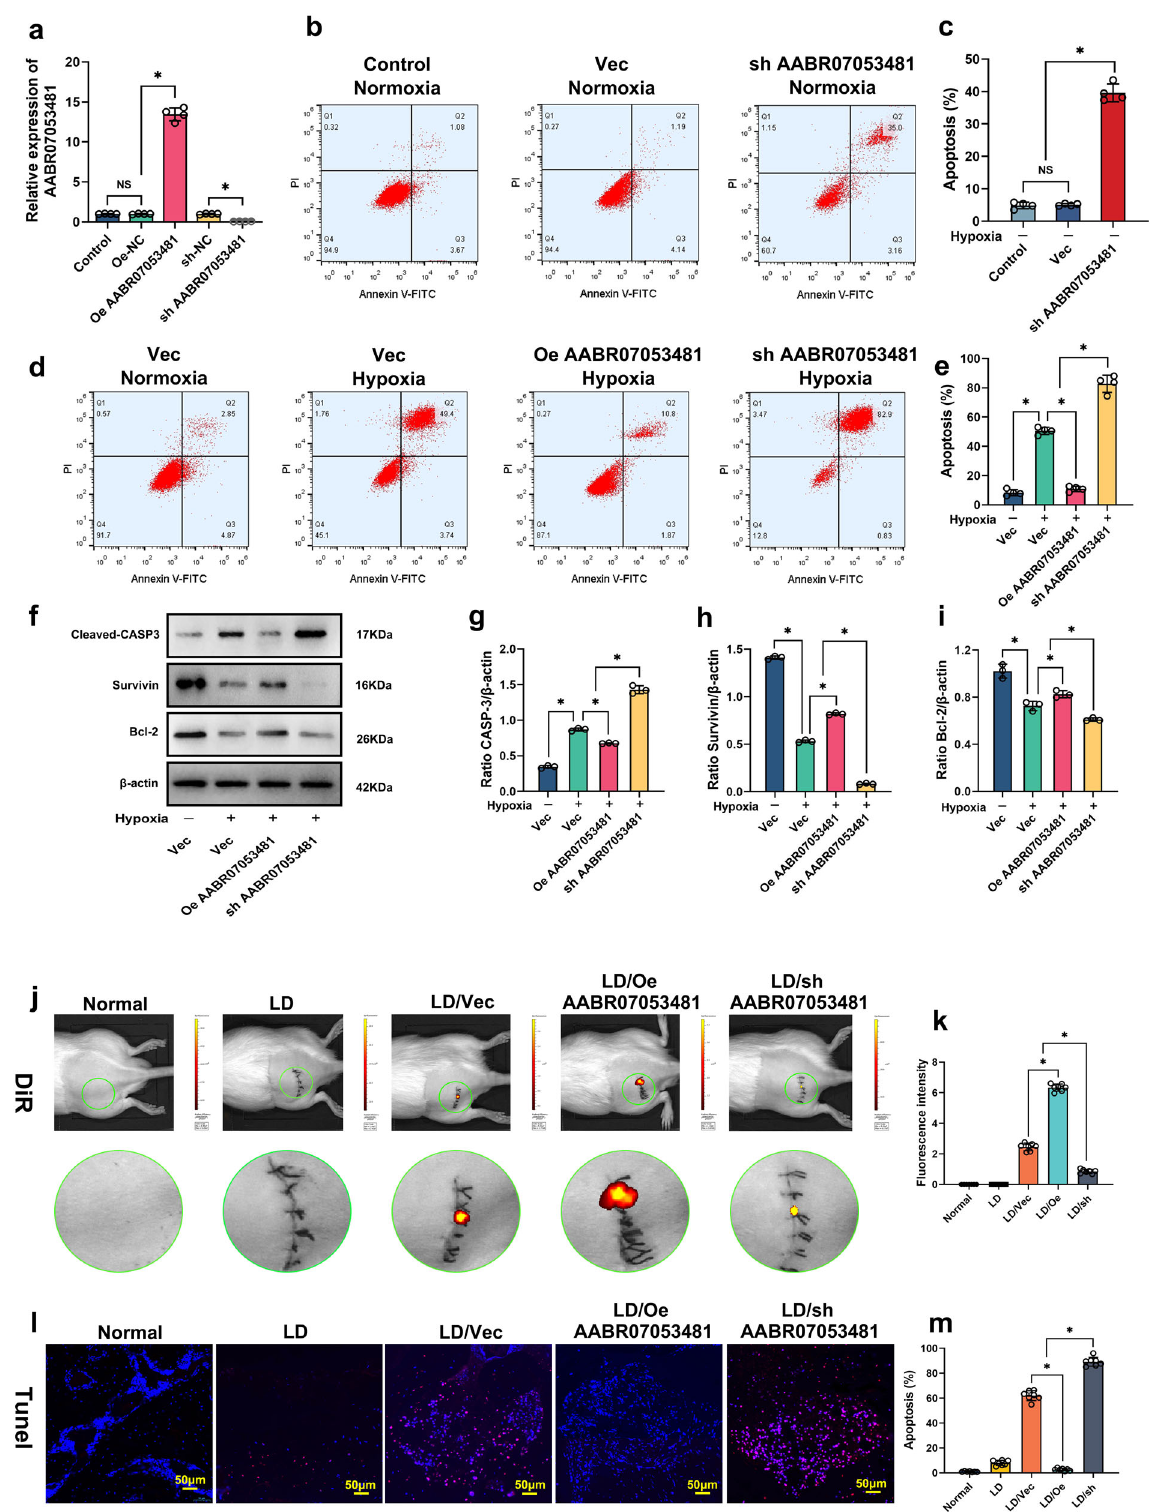
Fig. 2 LncAABR07053481 can inhibit hypoxia-induced apoptosis of BMSCs. a The expression of LncAABR07053481 was detected by qPCR ( n = 4). b – e Detection of BMSC apoptosis under different conditions by Annexin V- fl uorescein isothiocyanate (FITC, green)/propidium iodide (PI, red) ( n = 4). f – i The expression levels of CASP-3, Survivin, and Bcl-2 were detected by western blotting ( n = 3). j Forty-eight hours after surgery, the fl uorescence intensity of 1,1-dioctadecyl-3,3,3,3-tetramethylindotricarbocyanine iodide (DiR, red) in the transplantation area was detected by live imaging of small animals ( n = 7). k Quantitative analysis of DiR fl uorescence intensity in the transplanted area ( n = 7). l – m At 48 h after surgery, TdT-mediated dUTP nick- end labeling (TUNEL, red) /4 ’ ,6-diamidino-2-phenylindole (DAPI, blue) was used to detect apoptosis in the transplantation area ( n = 7). Data were shown as mean ± S.D. * P < 0.05; in ( a , c , e , g – i , k , m ), statistical signi fi cance was calculated by one-way ANOVA with Tukey ’ s post hoc test.